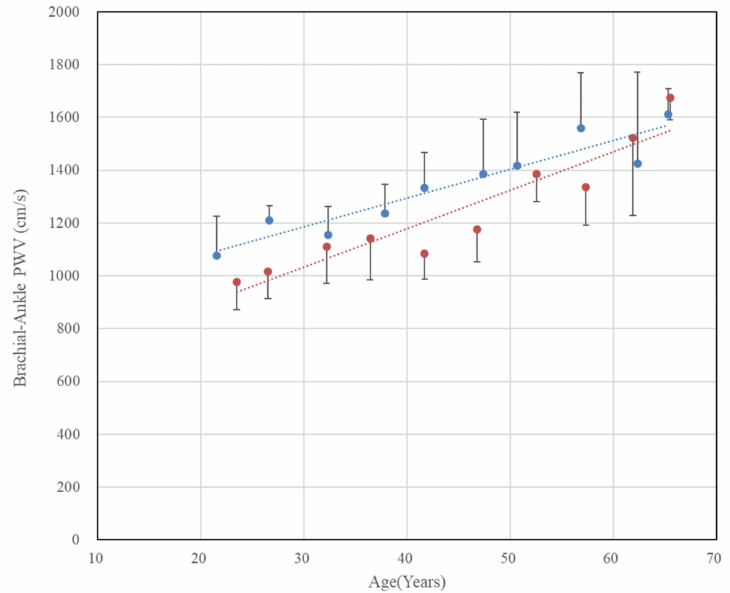
Figure 6. Chronological changes in brachial–ankle pulse wave velocity (baPWV) in both genders. The error bars represent the standard deviations (blue: males, r = 0.94, p < 0.0001, red: females, r = 0.94, p <